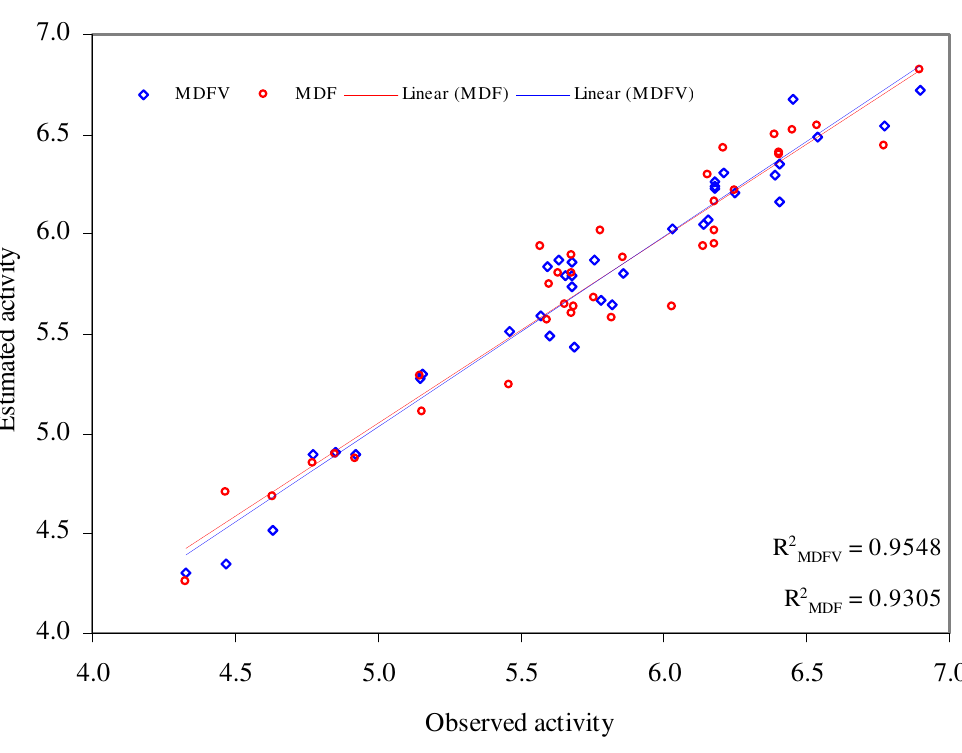
FIGURE 2 . Goodness-of-fit of models: MDFV vs.